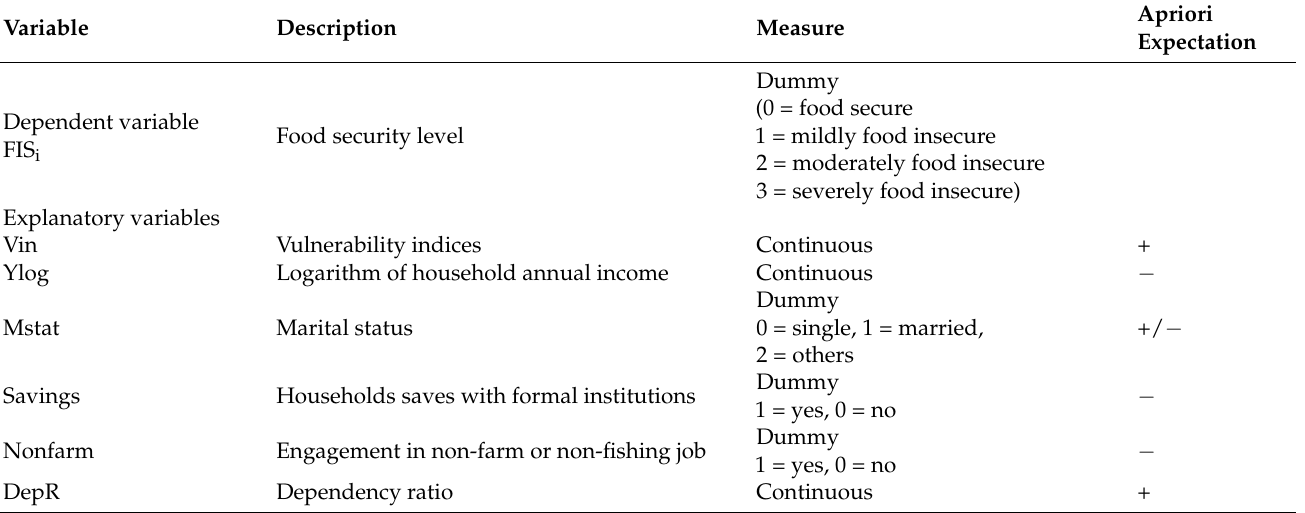
Table 2. Description of explanatory variables and hypothesized